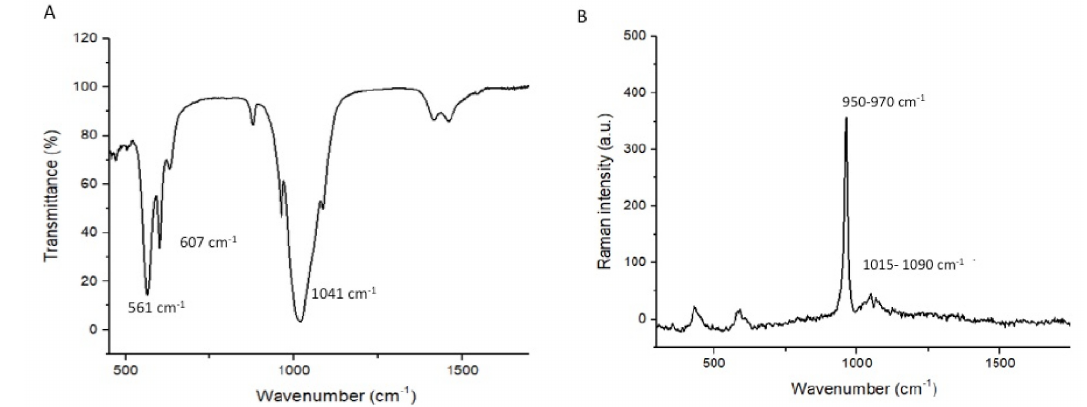
Figure 2. The FTIR analysis of the β -tricalcium phosphate is shown in ( A ). The band at 1041 cm − 1 indicates the stretching mode of PO 4 3 − group and peaks at 561 and 607 cm − 1 represent PO 4 3 − in β -TCP. ( B ) Raman spectrum of tricalcium phosphate indicates the internal vibration of the PO groups. The symmetric stretching ( ν 1) of P-O bonds show peaks at around 950 cm − 1 and 970 cm − 1 . At 1015—1090 cm − 1 range, asymmetric stretching ( ν 3) was